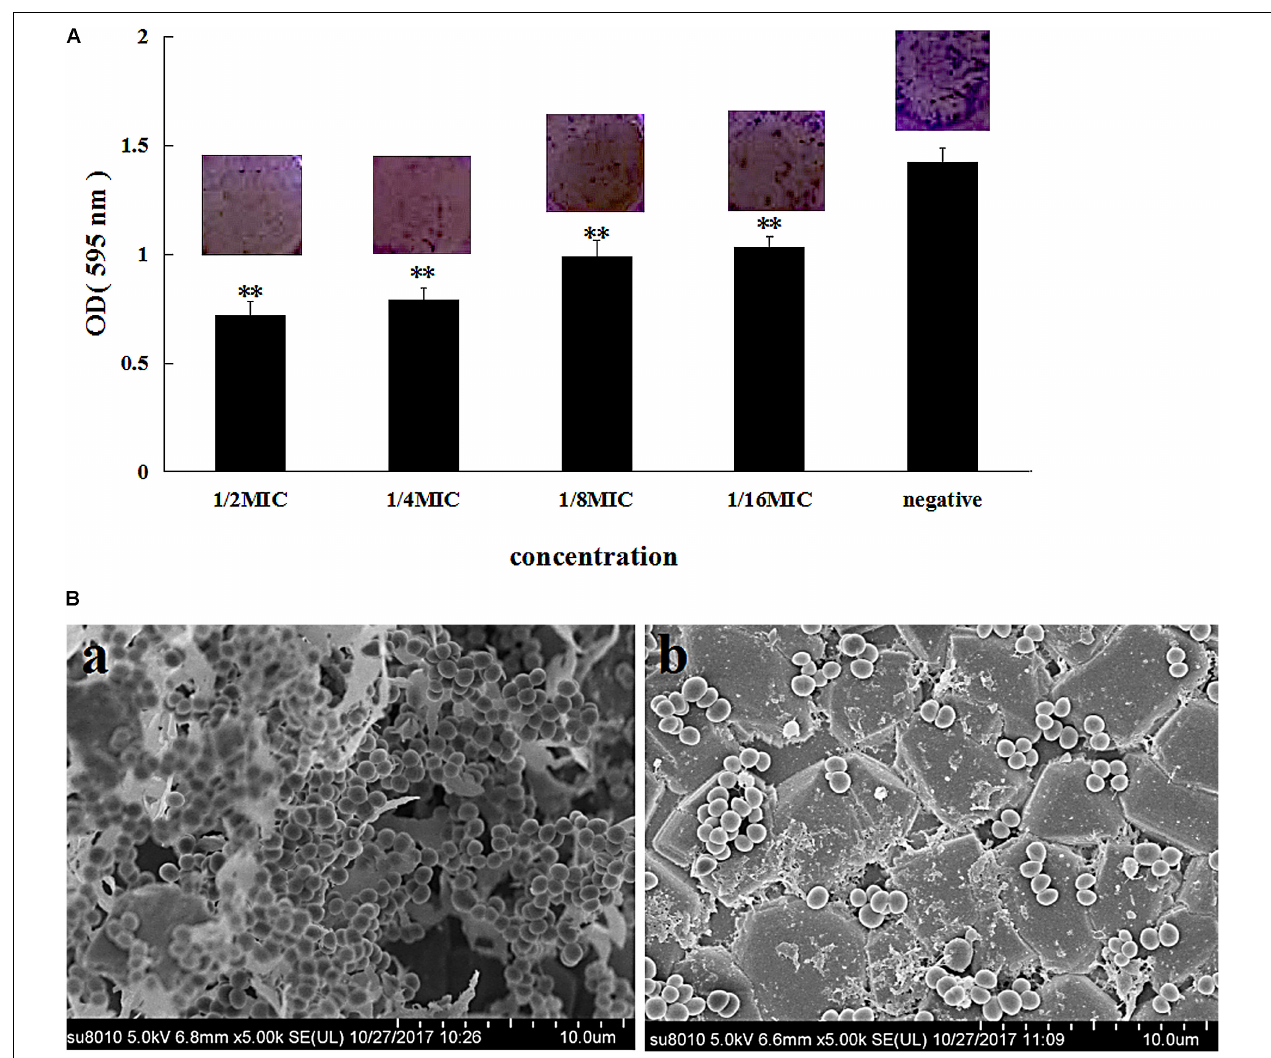
Figure 1 | Effect of azithromycin on biofilm formation by Staphylococcus xylosus ATCC 700404. (A) Determination of biofilm formation by TCP. (B) SEM images of biofilm formation by cells untreated (a) or treated with azithromycin (1/2-MIC; b ). Data are expressed as the mean + standard deviation (SD). A significant decrease ( ∗∗ P < 0.05) was observed, compared to the control ( in vitro biofilm